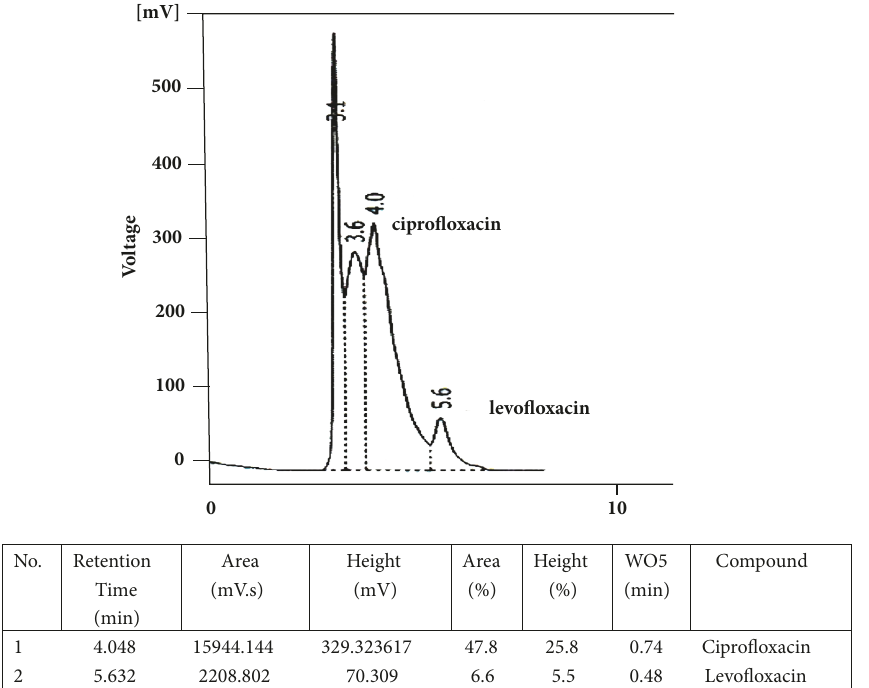
Figure 4: Chromatogram (HPLC-RF) of target antibiotics ciprofloxacin and levofloxacin at the Al-Wihda plant. Ciprofloxacin is represented by the third peak (3.6) and levofloxacin by the fourth peak (5.6) during 10min.